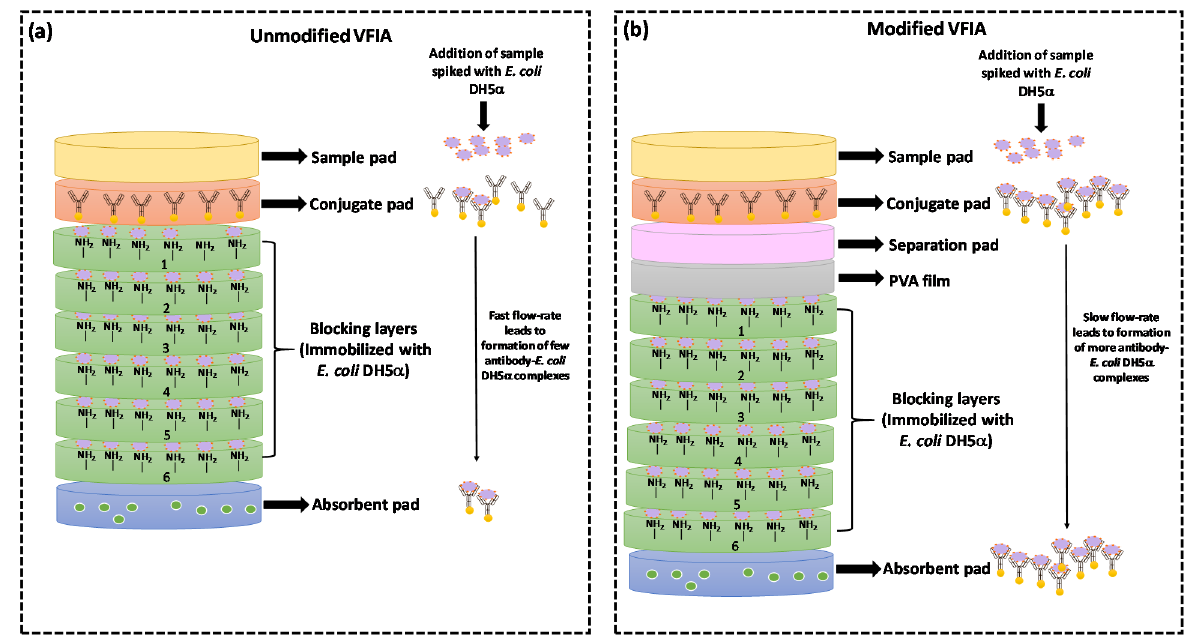
Figure 7. Schematic of ( a ) unmodified and ( b ) modified VFIA set-up with an integrated PVA film. For the unmodified VFIA, the fast flow rate of the sample leads to the formation of fewer antibody- E. coli DH5 α complexes. In modified VFIA, delayed flow rate due to the presence of PVA film leads to enhanced sensitivity.